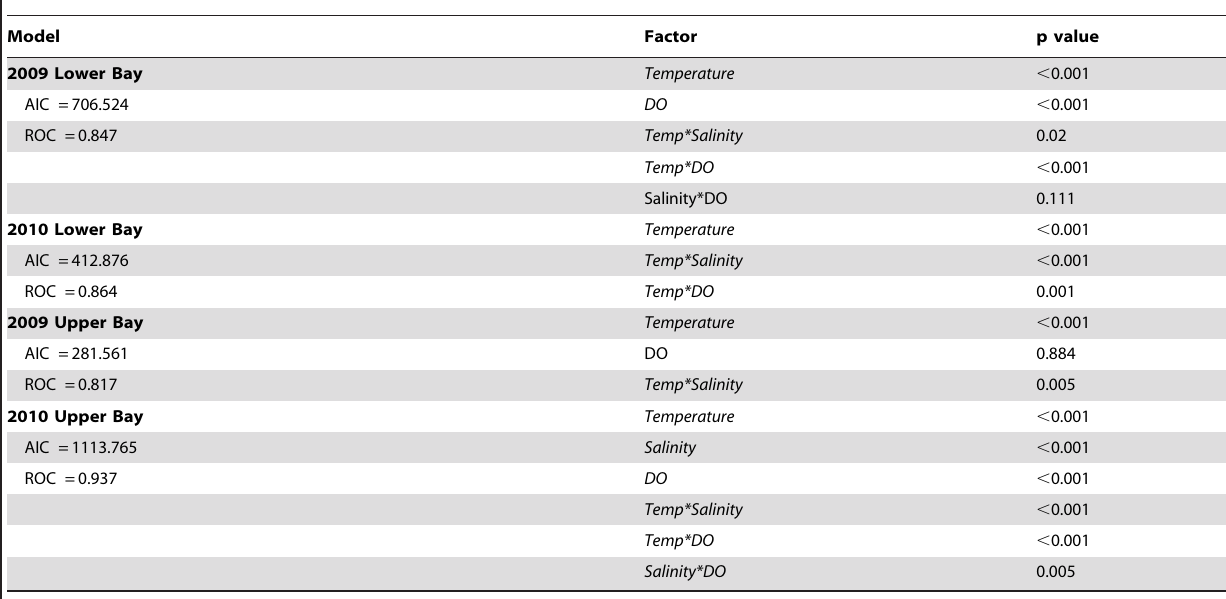
Table 2. Summary of predictive model results.